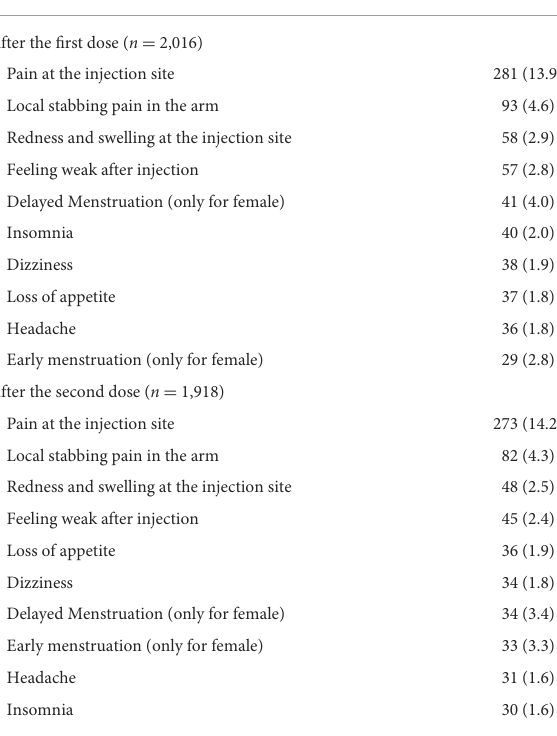
TABLE 6 Top 10 incidences of adverse events after